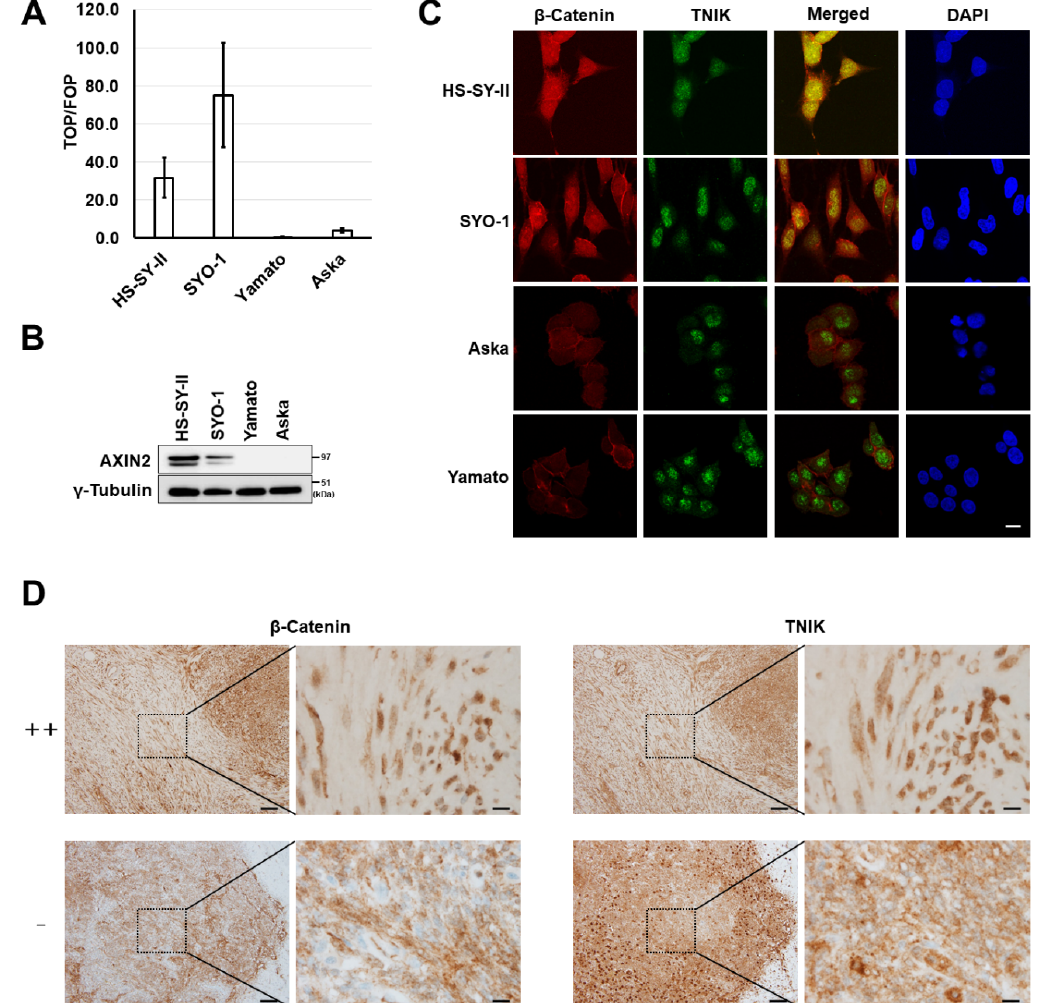
Figure 1. Wnt activation in synovial sarcoma. ( A ) T-cell factor (TCF)/lymphoid enhancer factor (LEF) transcriptional activity of synovial sarcoma cells. Four synovial sarcoma cell lines (HS-SY-II, SYO-1, Yamato, and Aska) were transfected with the super-TOP flash or super-FOP flash luciferase reporter, and their luciferase activity was measured 24 h later. Data represent the mean TOP / FOF ratio ( ± S.D.) of three replicates. ( B ) Expression of the axis inhibition protein 2 (AXIN2) and γ-tubulin (loading control) proteins determined by immunoblotting. ( C ) Dual immunofluorescence analysis of β-catenin and Traf2-and-Nck-interacting kinase (TNIK) protein expression in synovial sarcoma cells. Scale bar: 20 µ m. ( D ) Immunohistochemical analysis of the β-catenin and TNIK proteins in clinical specimens of synovial sarcoma. Representative cases with strong positive (++) and negative (−) nuclear β-catenin expression are shown. Scale bars: 100 µ m in low-power views (left) and 10 µ m in high-power views